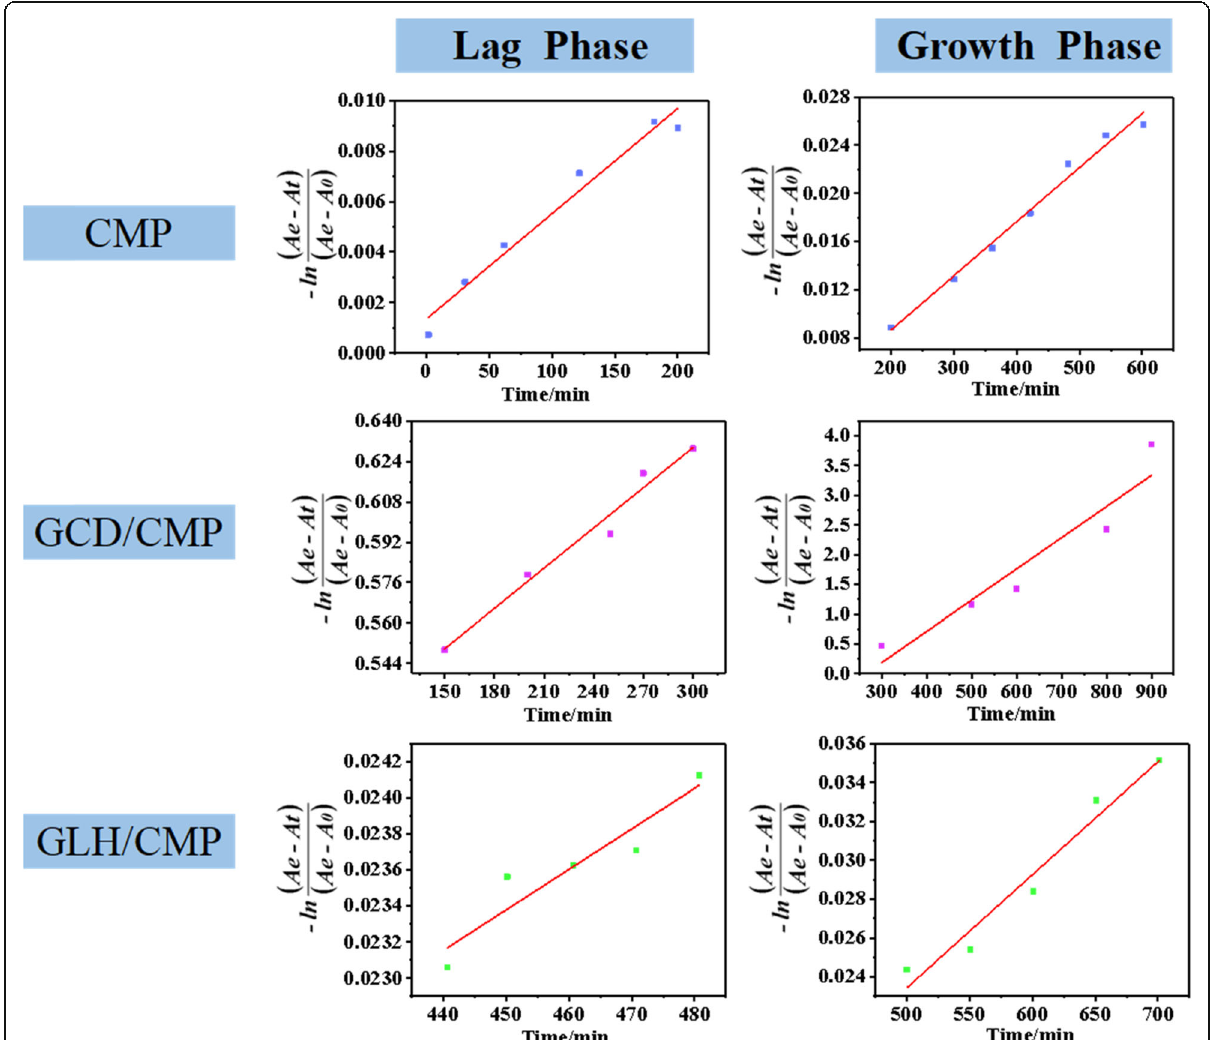
Fig. 4 Dynamic curve of nucleation stage and growth stage